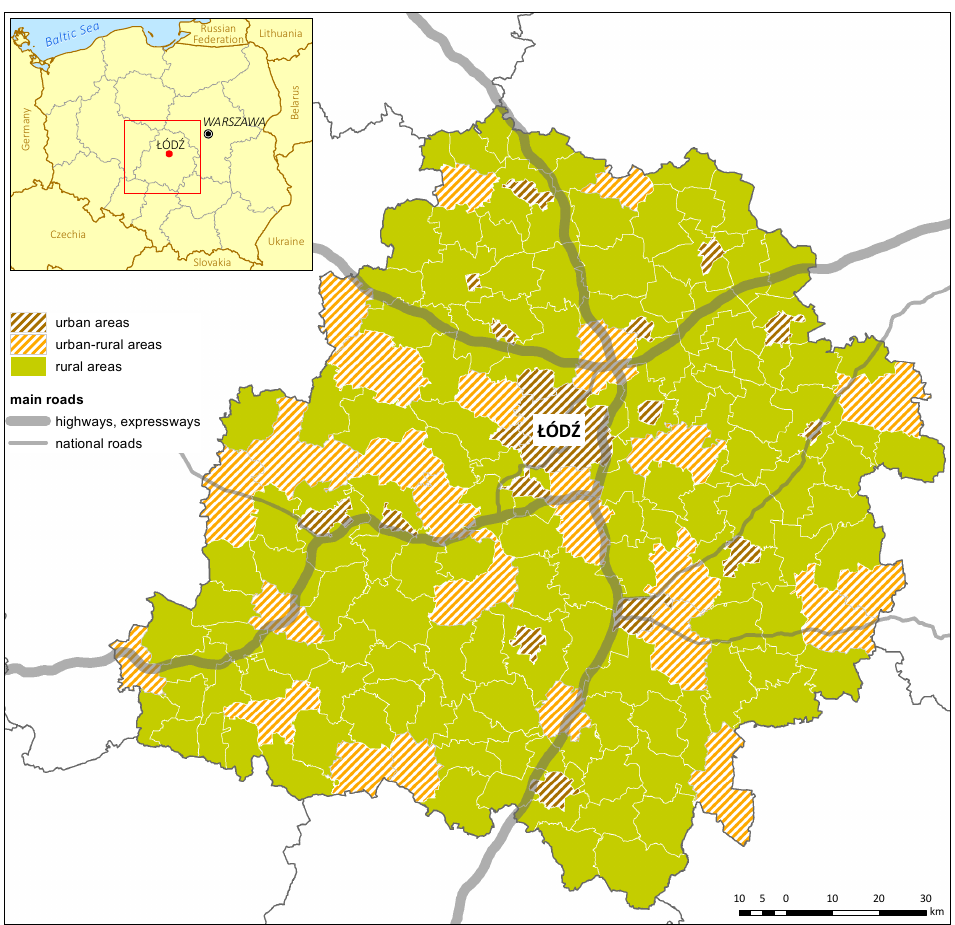
Figure 2. The location and administrative structure of the study